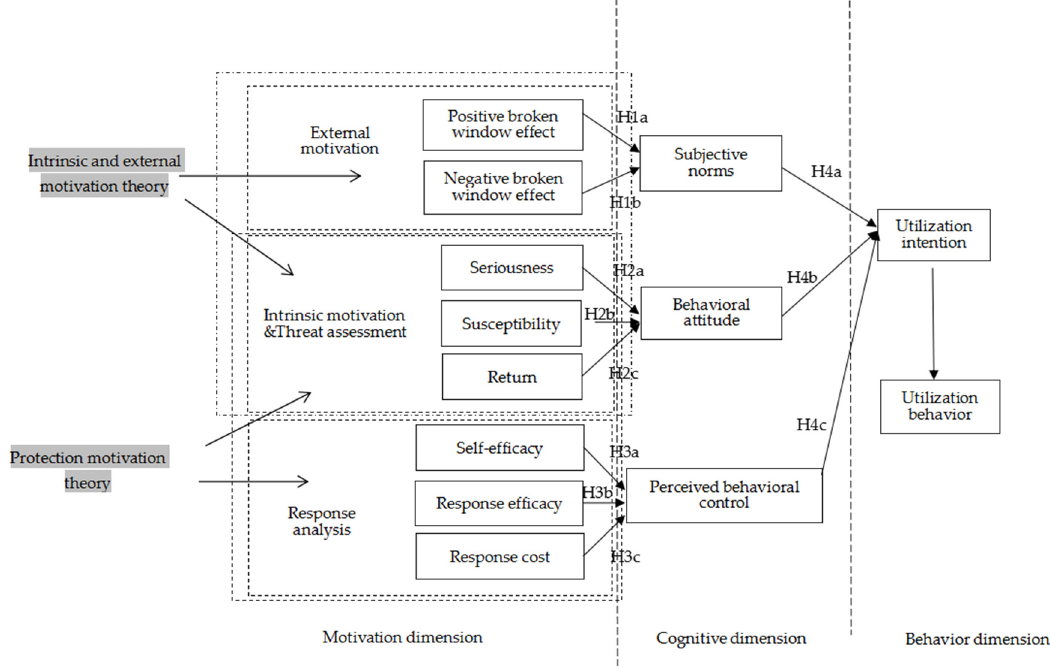
Figure 1. Analysis Framework.